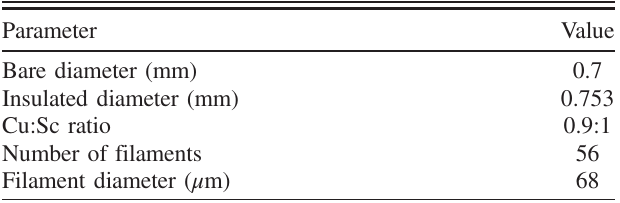
TABLE II. Parameters of Supercon 56S53 NbTi wire [14].